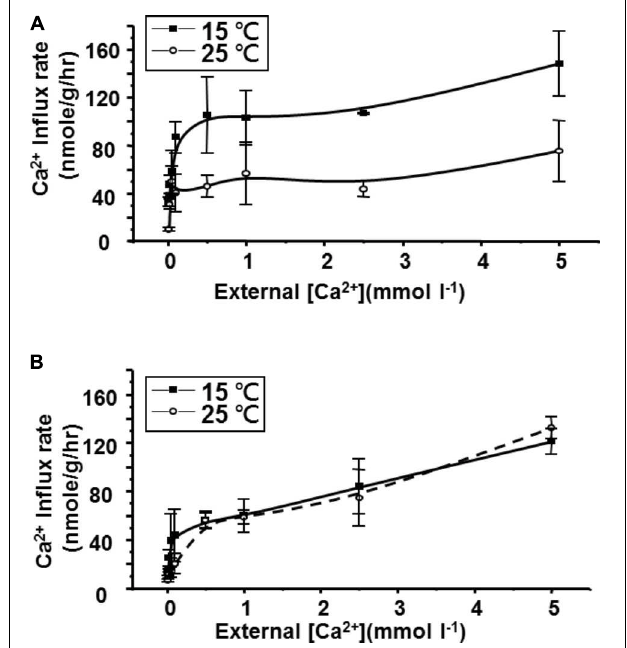
FIGURE 2 | Comparison of Ca 2 + influx kinetics after 2 weeks cold (15 ◦ C) acclimation or control (25 ◦ C) for (A) goldfish and (B) tilapia. Calcium influx was measured in tracer media over a range of calcium concentrations. The mean (closed squares for 15 ◦ C acclimated and open circles for 25 ◦ C acclimated) and deviation (bar) were obtained from four fish for each point ( n = 4).